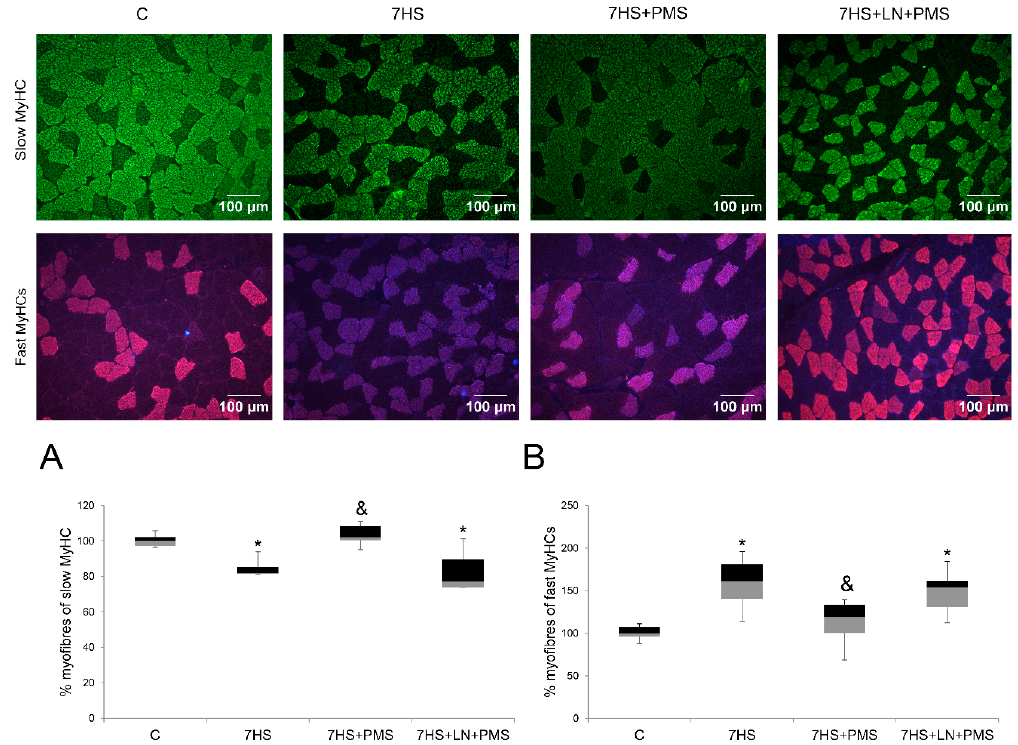
Figure 2. Immunohistochemical analysis of slow ( A ) and fast ( B ) fiber number on rat soleus cross-sections in the control group (C), 7-days hindlimb-suspended group (7HS), 7-days hindlimb suspended group with plantar mechanical stimulation (7HS + PMS) and 7-day hindlimb suspended group with plantar mechanical stimulation+ L-NAME introduction (7HS + LN + PMS). Data are shown as % of the control group. *—significant difference from the control group. &—significant difference from 7HS group ( p < 0.05). Box plots show 25–75 percentiles and median values and the whiskers represent the minimum and the maximum; n = 8/group.